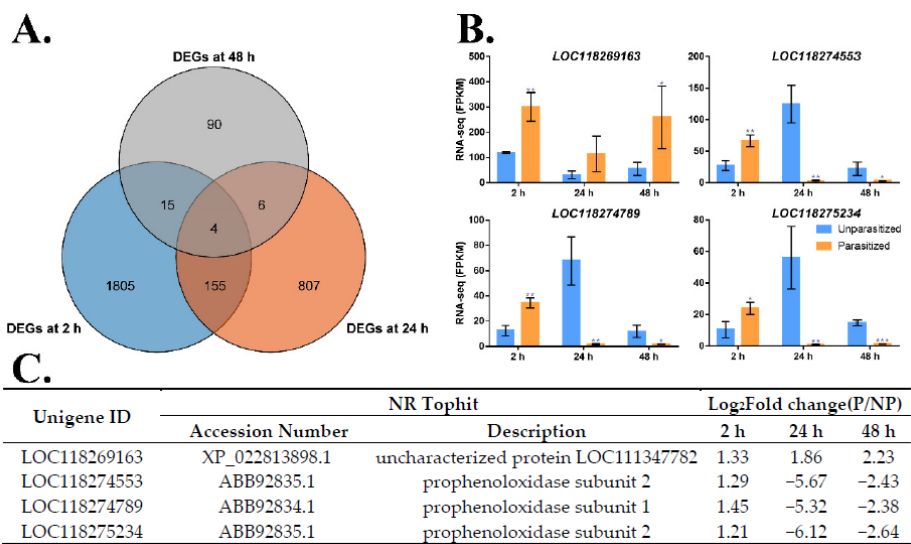
Figure 4. Identification of common DEGs at 2 h, 24 h, and 48 h post-parasitization with M. manilae . ( A ) Venn diagram of DEG numbers between unparasitized and parasitized FAW larvae at 2 h, 24 h, and 48 h. ( B ) The comparisons of FPKM in four common DEGs between unparasitized and parasitized host larvae and data were presented as mean ± SE ( n = 3). ( C ) List of the four common DEGs and their functional annotations in the NR database.